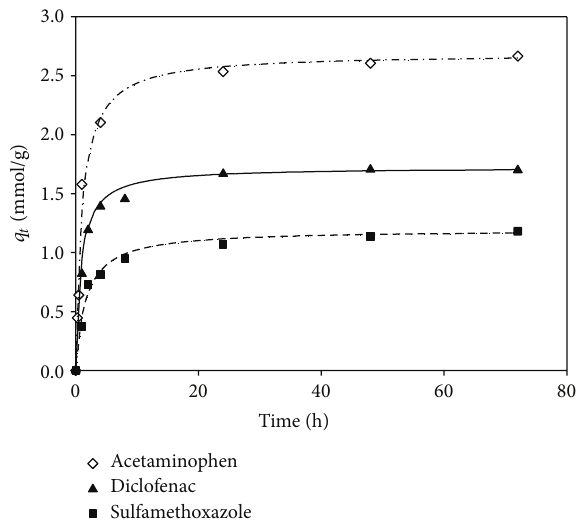
Figure 2: Determination of the pseudo-second-order kinetic model onto GAC; pseudo-second-order kinetic model: diclofenac, acetaminophen, and sulfamethoxazole (stirring speed of 140 rpm in 25 ∘ C with particle size of 60 × 80 mesh. The initial concentration of each target compound was 10 mg/L).